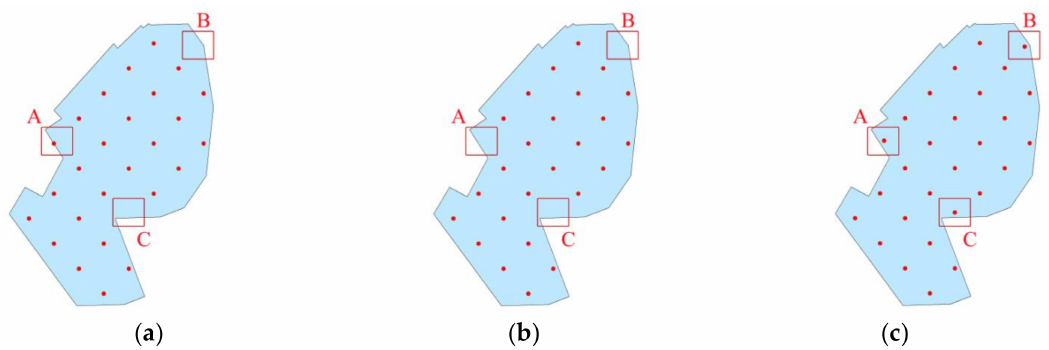
Figure 13. Regular area 2. ( a ) Filling using the traditional three-square type method. ( b ) The effect of the filling method based on simple segmentation. ( c ) The effect of the method proposed in this